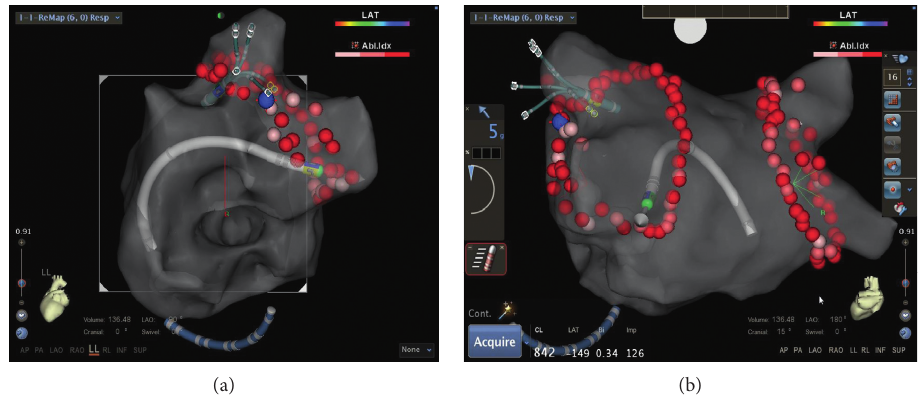
Figure 3: Radiofrequency catheter ablation of paroxysmal atrial fibrillation accomplished in the F group.